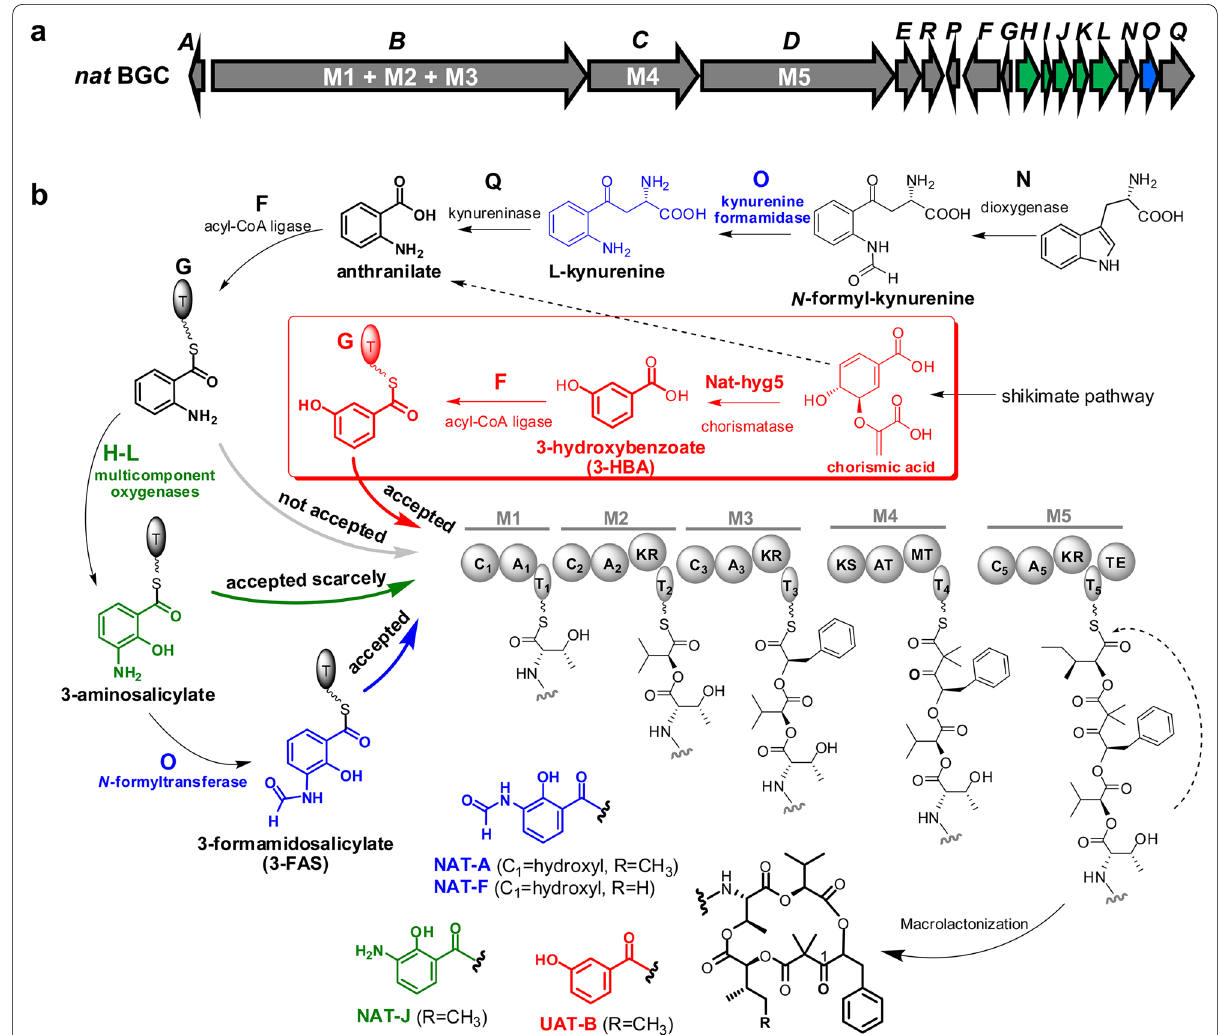
Fig. 1 The gene organization of the NAT biosynthetic gene cluster ( nat BGC) ( a ) and the biosynthetic routes of the starting precursor for the NAT NRPS‑PKS assembly line ( b ). The genes and related products of nat H‑L and nat O are marked in green and blue, respectively. The bio‑reaction schemes of 3‑hydroxybenzoate (3‑HBA) generation and loading processes are highlighted in red. The dashed arrow represents that